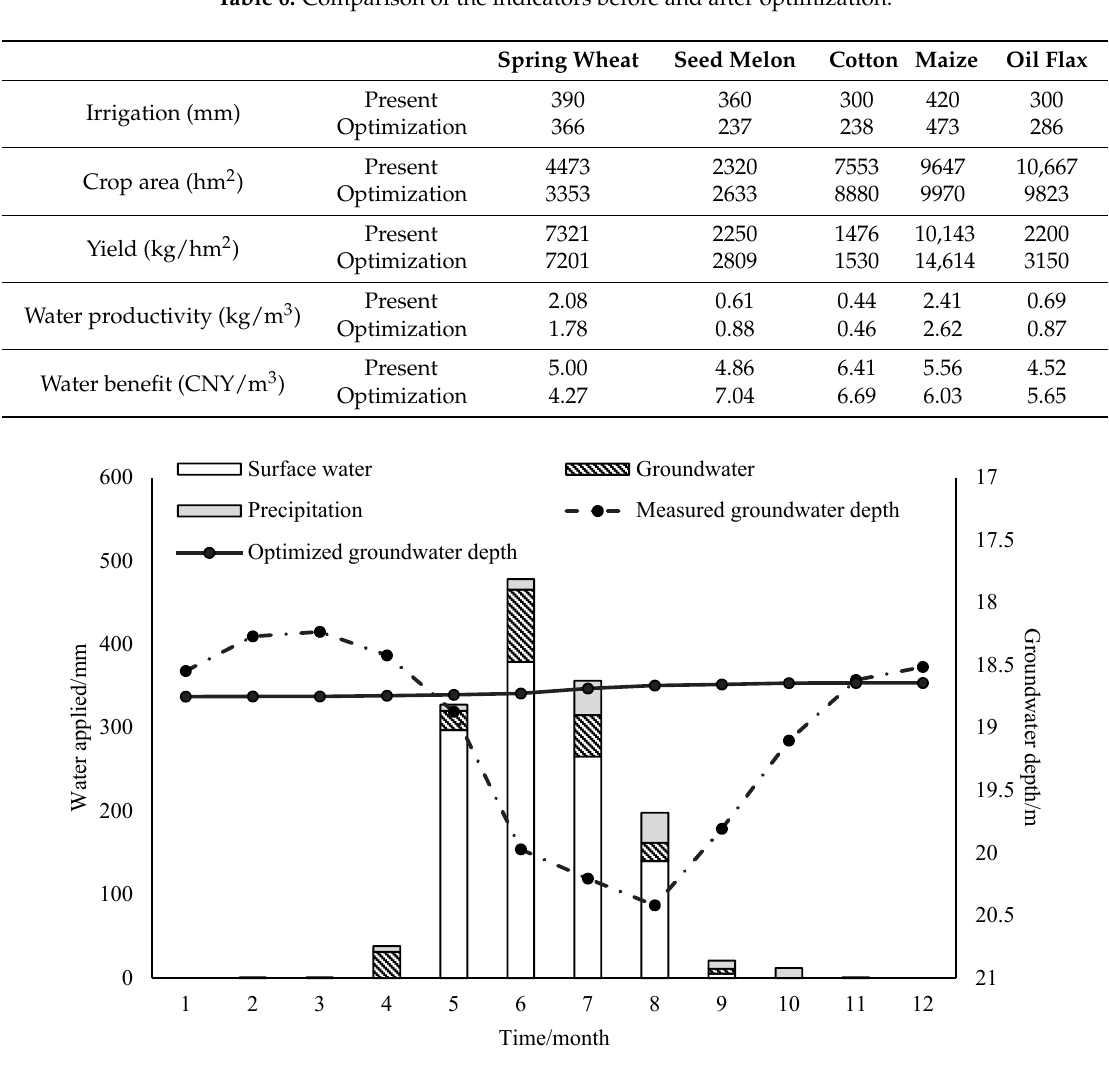
Figure 8. Water distribution and groundwater level changes in each month of 2014.